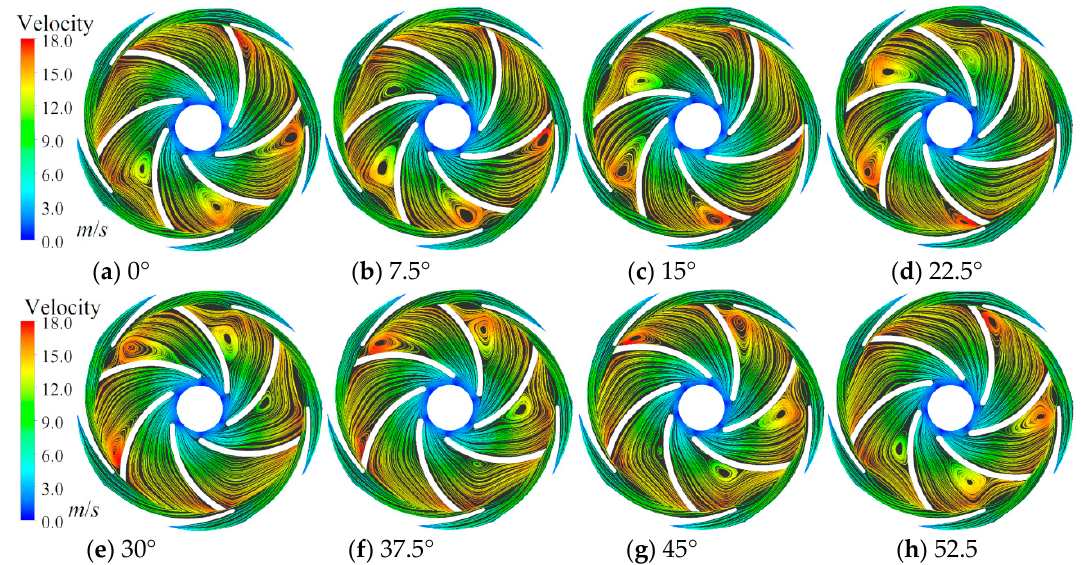
Figure 11. Evolution processes of the vortices in the stator and rotor cascade during a 1/6 period of impeller rotation under condition 0.2 Q d .